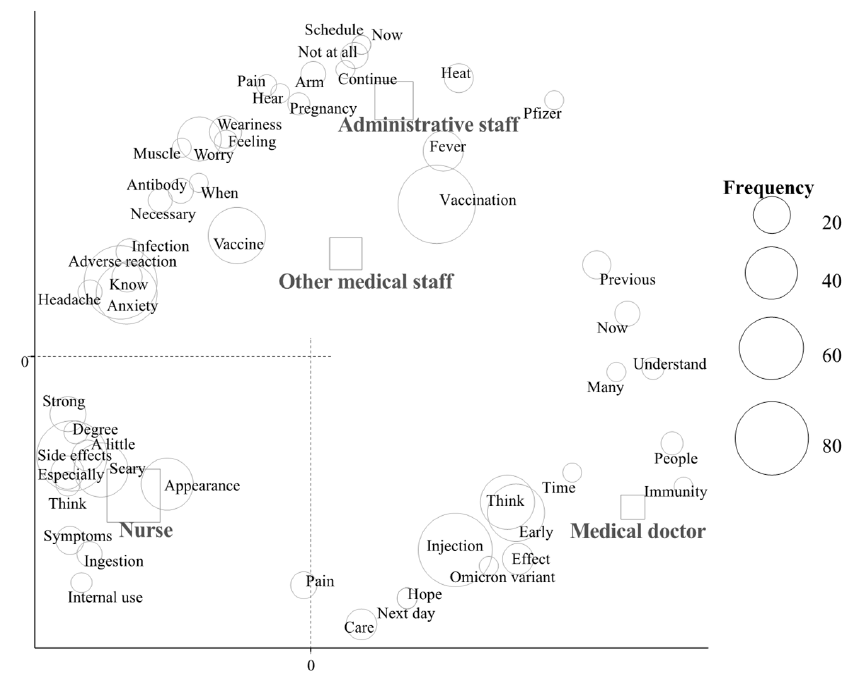
Figure 2. Correspondence analysis of the relationship between frequently used words and job title.